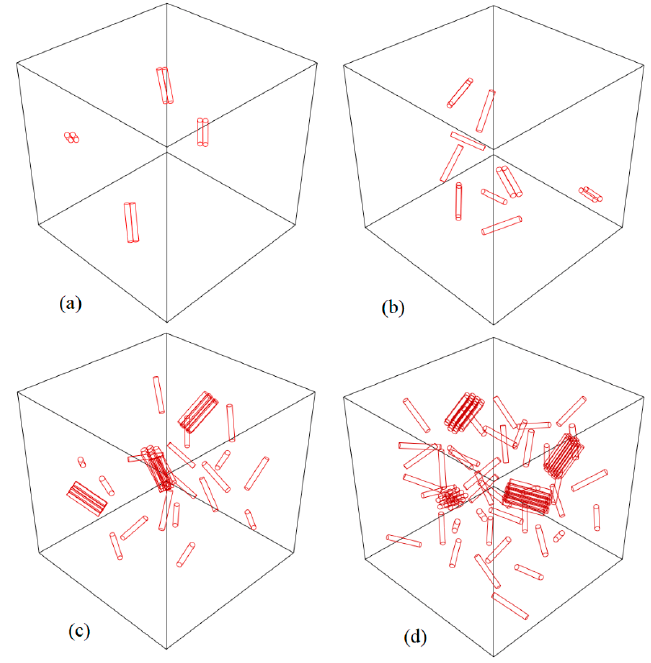
Figure 14. 3D view of the RVE with clustering of CNTs in four colonies: ( a ) 0.18 wt%; ( b ) 0.36 wt%; ( c ) 0.9 wt%; ( d ) 1.8 wt% (half of the EFs are clustered at four random point).